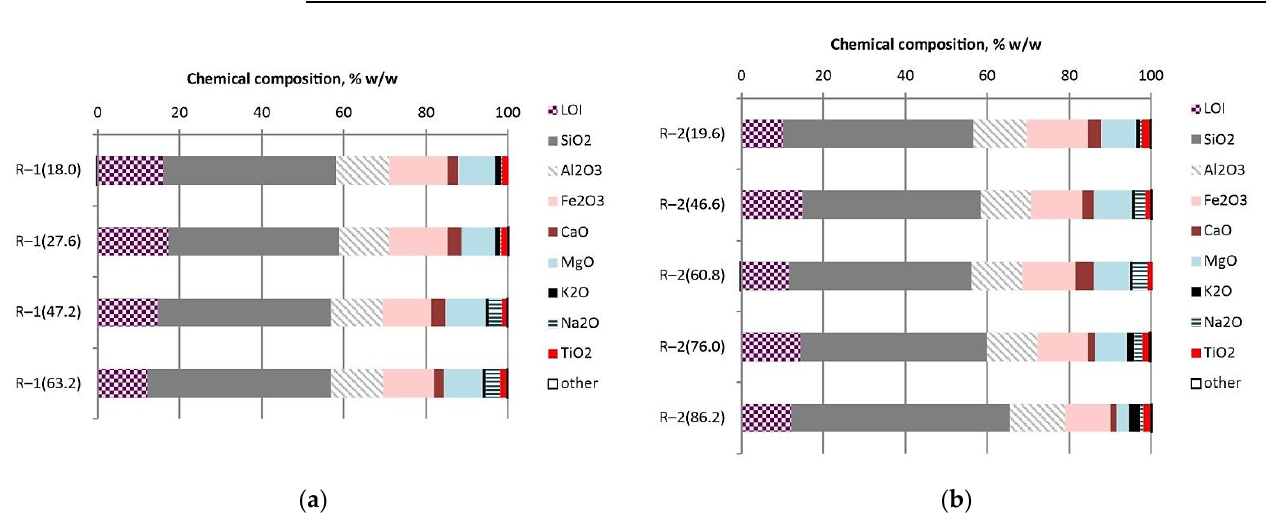
Figure 4. Chemical composition of volcanic tuff core samples from Radoshivka–1 well ( a ) and Radoshivka–2 well ( b ).